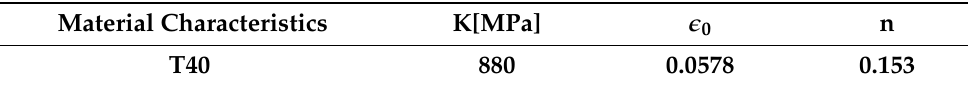
Figure 13. Comparison between experimental data and Swift model. Table 4. Swift law.